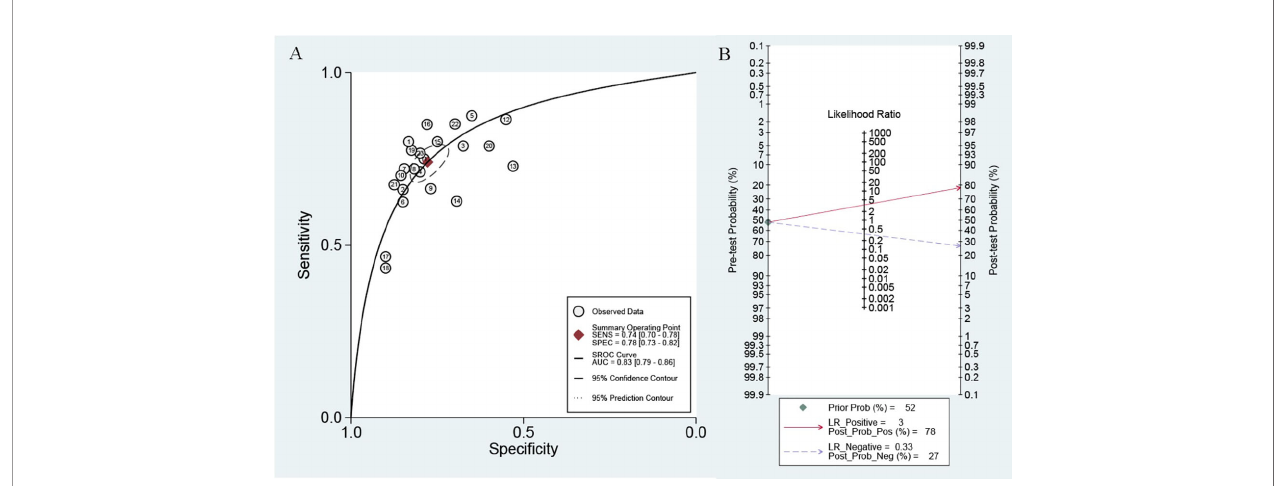
FIGURE 4 | (A) SROC curve with pooled estimates of sensitivity, speci fi city and AUC of overall studies. (B) Fagan ’ s nomogram for evaluation of post-test probabilities based on pooled estimates of PLR and NLR of overall studies.